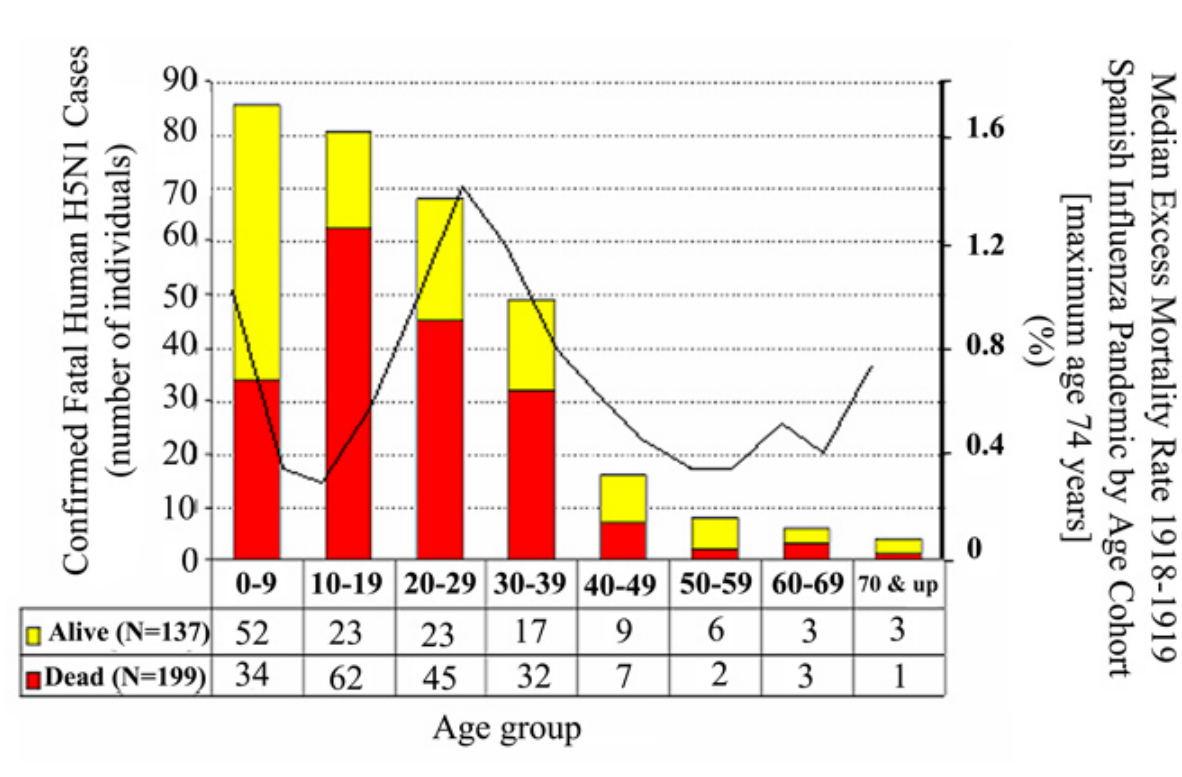
Fig. 2. Comparison of age-specific mortality from H5N1 “Bird Flu” and H1N1 “Spanish Influenza” viruses. Bar graph shows proportions of confirmed fatal and non-fatal human H5N1 cases by 10-yr age cohort as of September 2007 (data from WHO Regional Pacific Office, WHO Epidemic and Pandemic Alert and Response Network). Line graph (after Murray et al. 2006) shows estimated age specific excess mortality rates from the 1918-1919 H1N1 Spanish Influenza